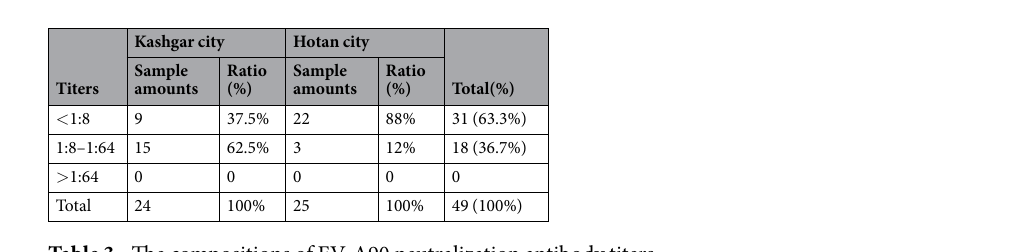
Table 3. The compositions of EV-A90 neutralization antibody